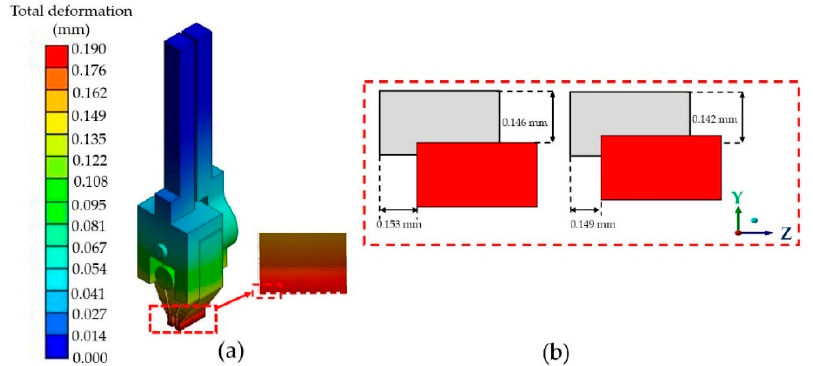
Figure 18. Total deformation from the structural simulation for the parallel WT: ( a ) overview and ( b ) an enlarged picture focusing on connecting areas in the yz plane.